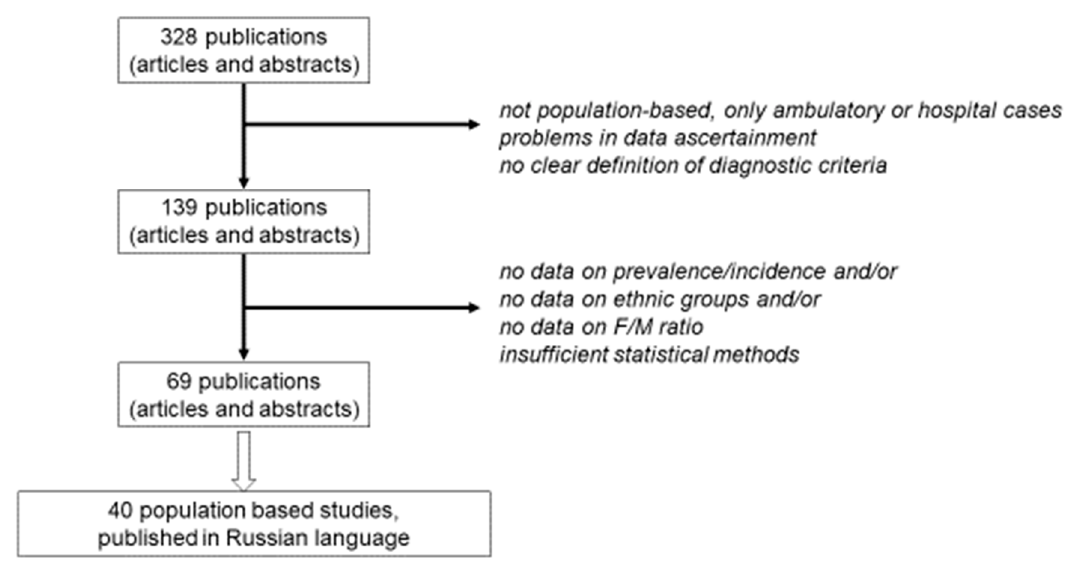
Figure 1. Methodology of the data